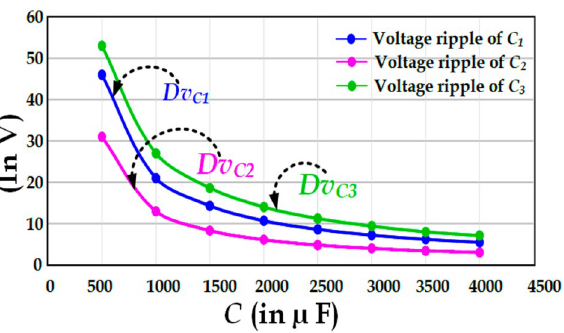
Figure 6. The capacitor voltage ripple vs the value of capacitance for the capacitors C 1 , C 2 , and C 3 .